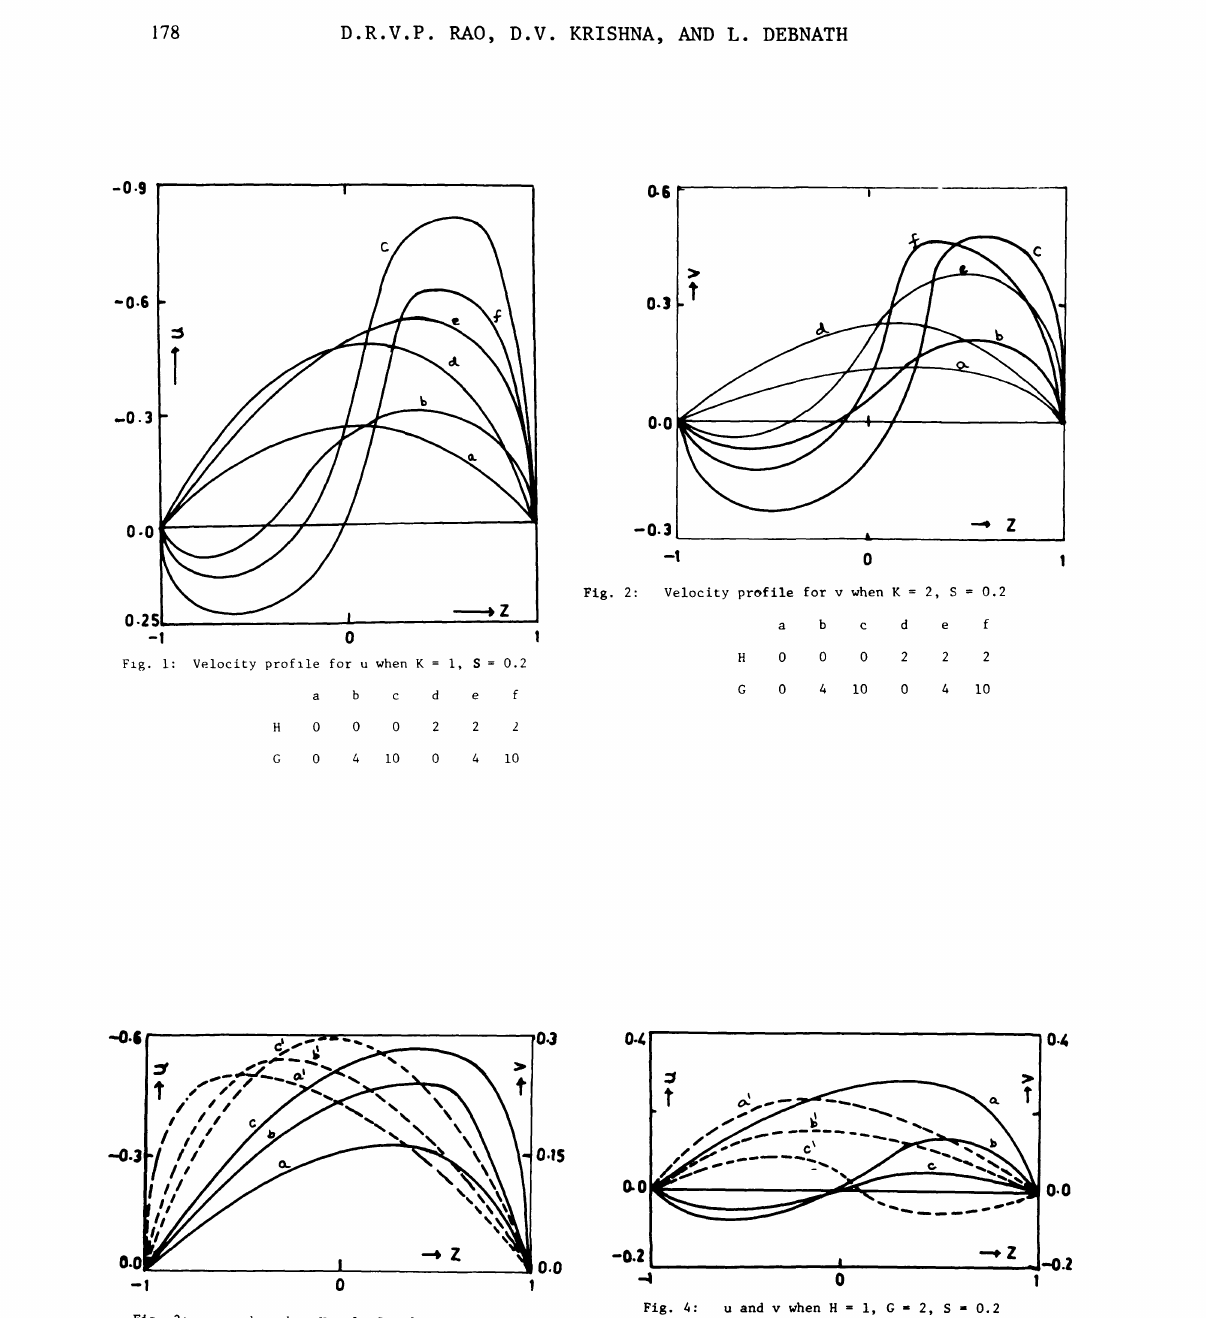
lg. 2: Veiocity profile for when K 2,